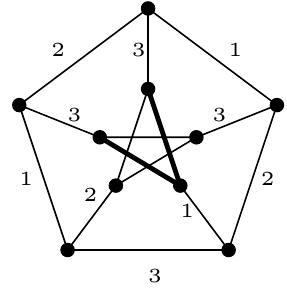
Figure 1: Edge-coloring the Petersen